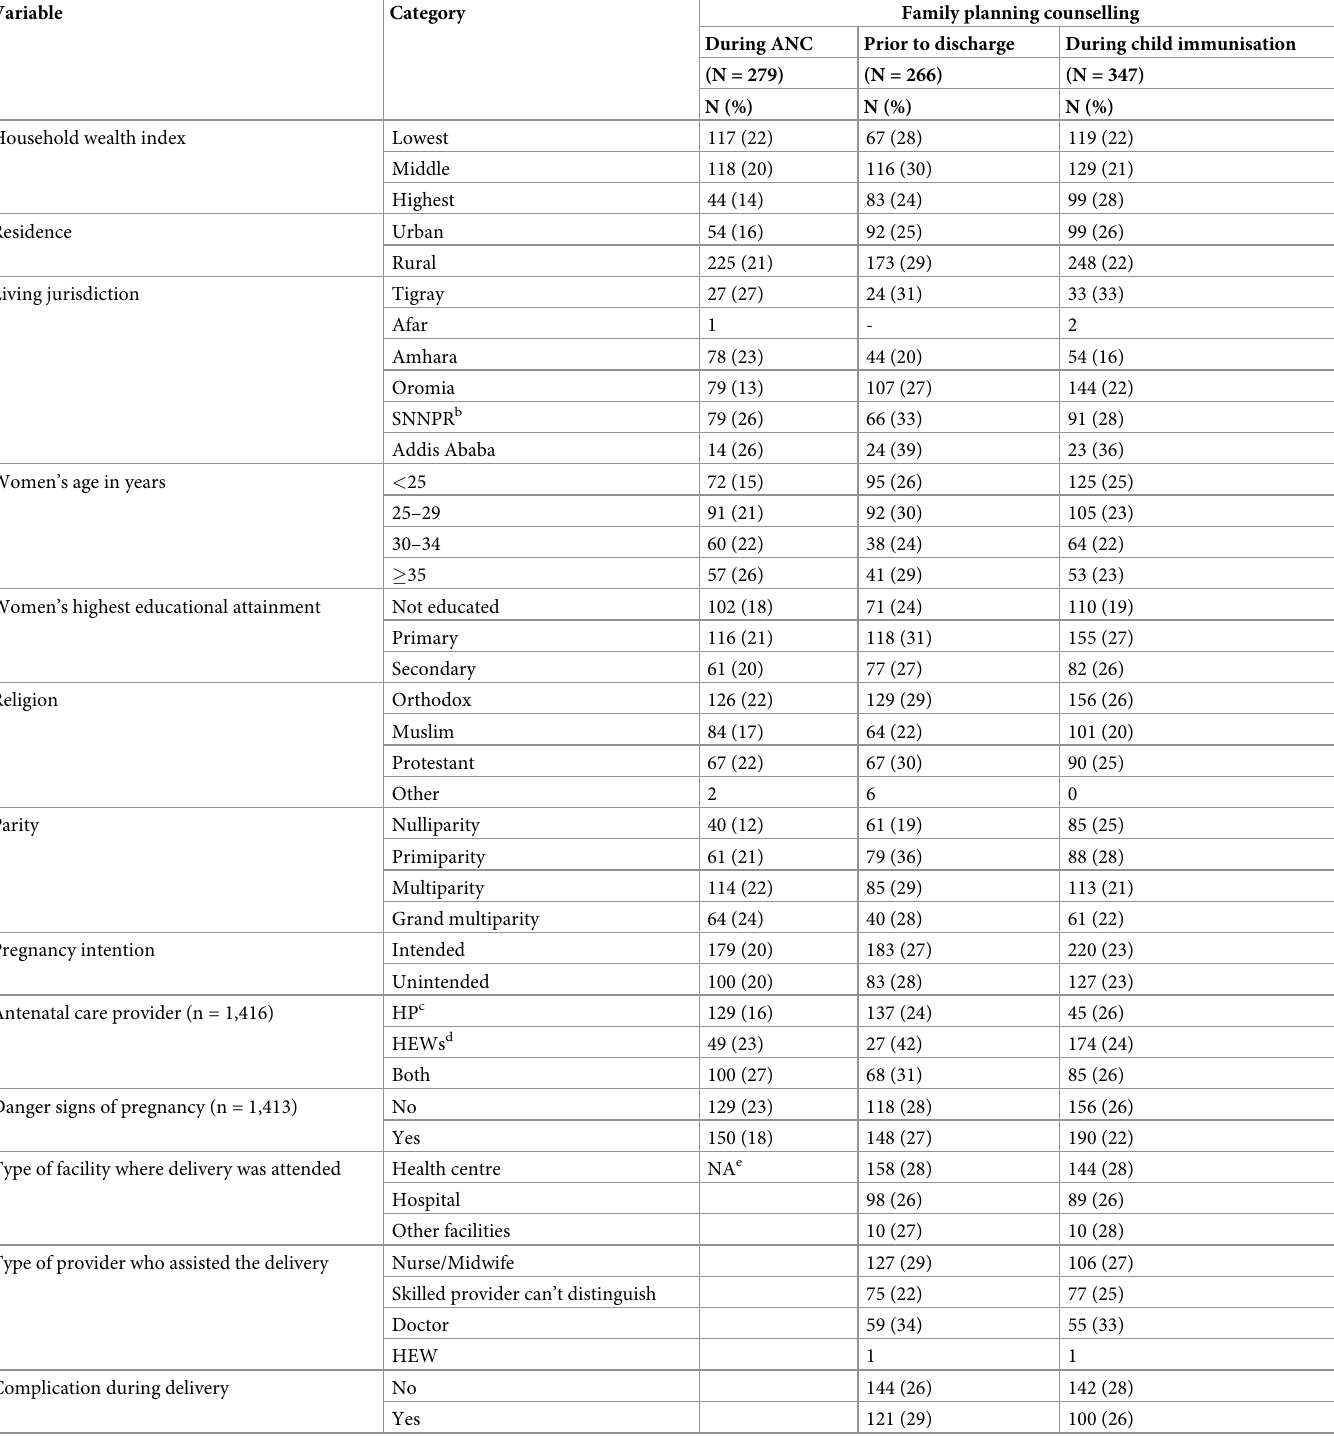
Table 1. Characteristics of study participants by family planning counselling provided at the different maternal health